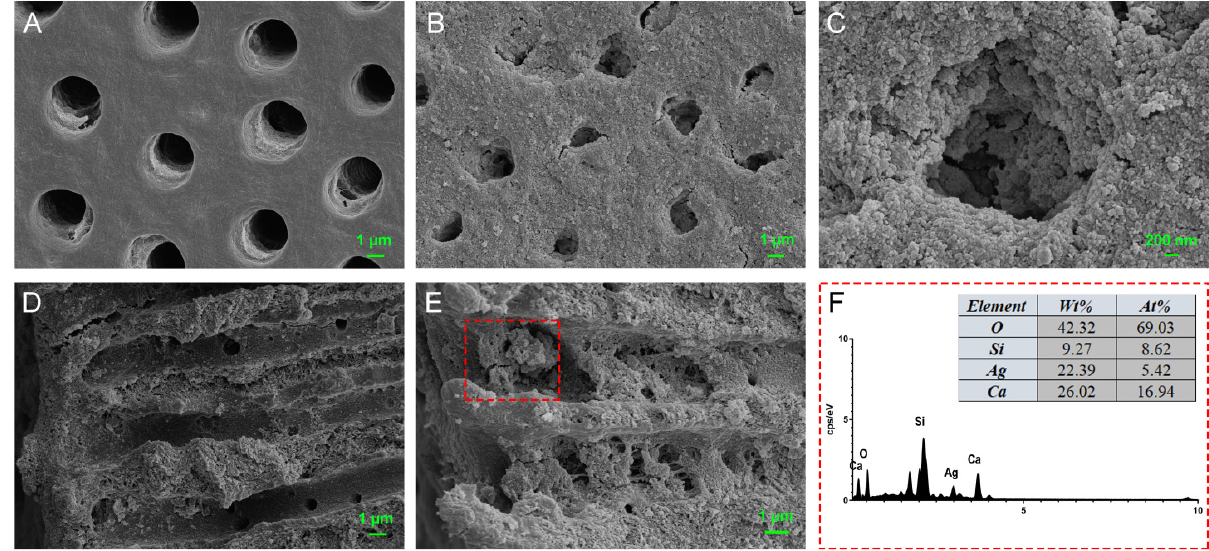
Figure 7. Infiltration of M-AgTX into dentinal tubules. ( A ) Original dentinal tubule openings ( A ) ×5000; ( B , C ) Tubule openings treated ultrasonically with M-AgTX ( B ) ×5000, ( C ) ×20,000); ( D ) Original dentinal tubule axial cross sections ( D ) ×5000; ( E ) Tubule axial cross sections after being treated with M-AgTX ( E ) ×7000; ( F ) EDS spectrum of selected square area in ( E ).